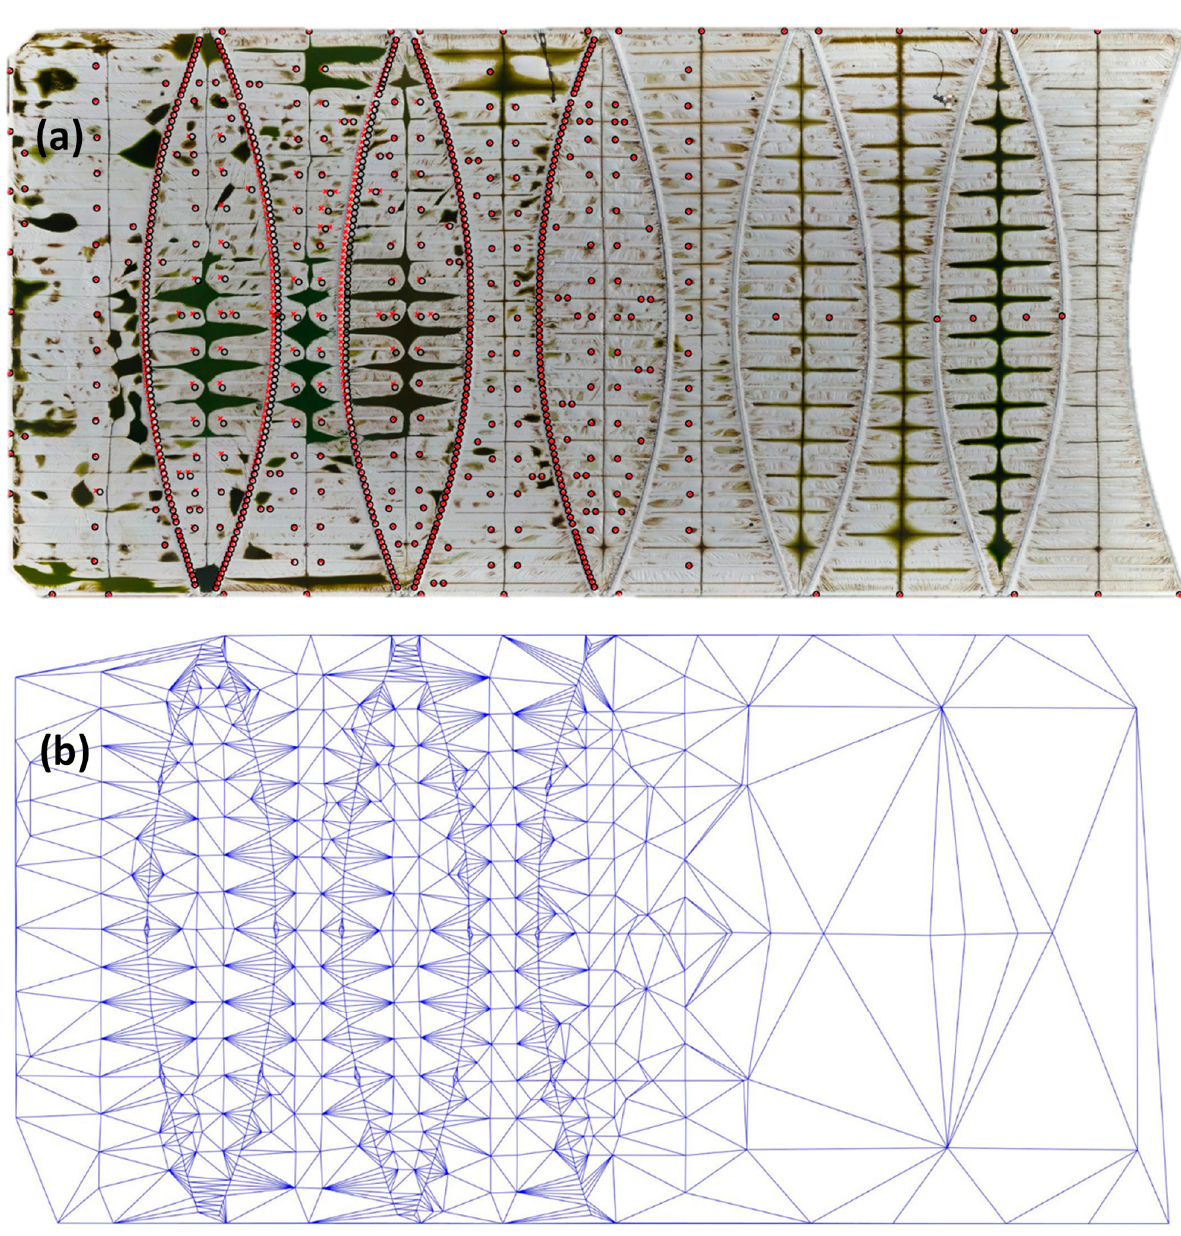
Figure 12. ( a ) Distinguishable features on the floating cover; ( b ) triangular mesh of the distinguishable features using Delaunay Triangulation algorithm in MATLAB.